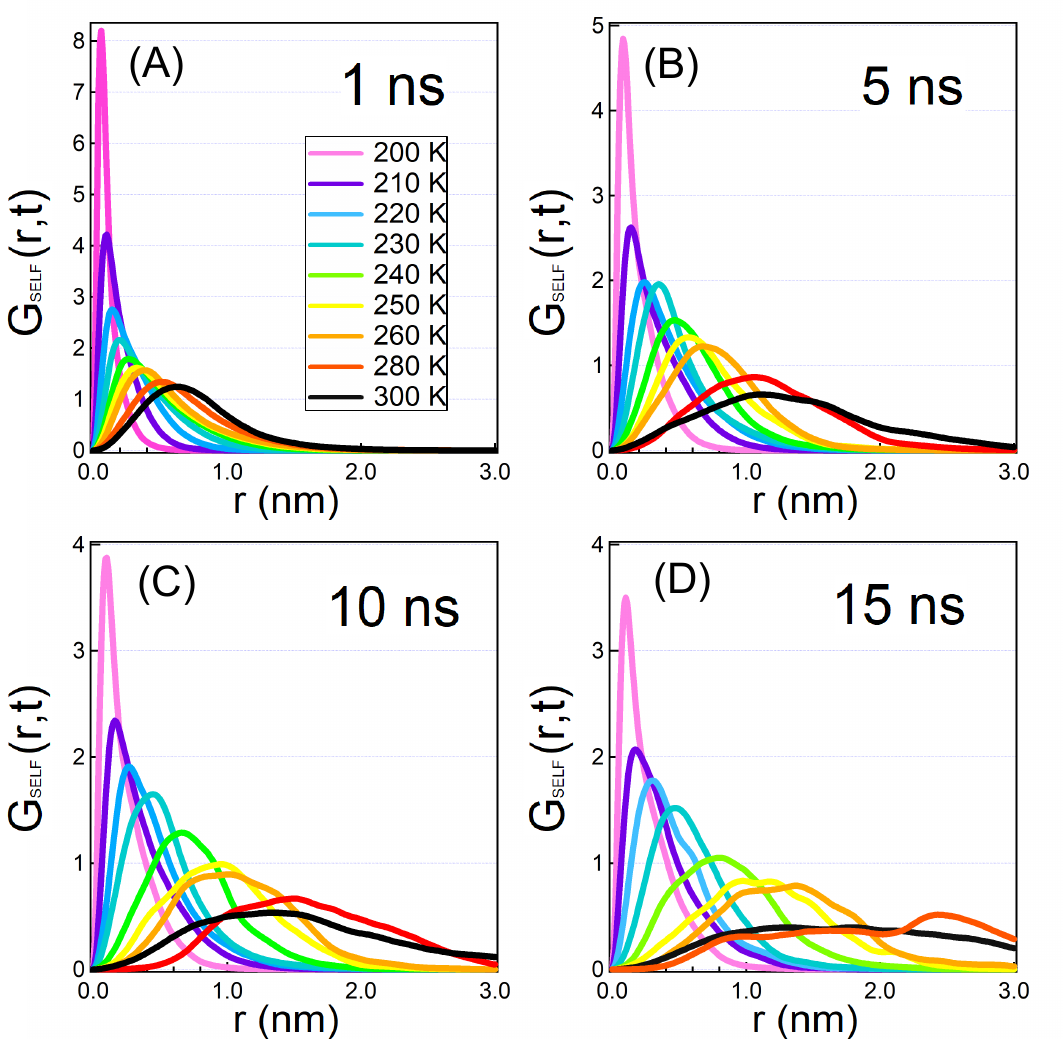
Figure 5. Long time SVHFs calculated from T = 200 K to 300 K for oxygens of hydration water. The panels correspond to four different correlation times: t = 1 ns ( A ), t = 5 ns ( B ), t = 10 ns ( C ) and t = 15 ns ( D